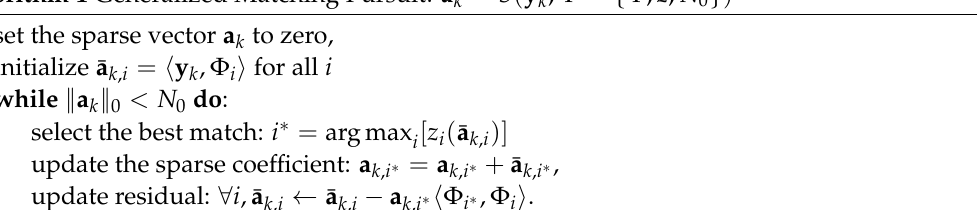
Algorithm 1 Generalized Matching Pursuit: a k = S ( y k ; Ψ = { Φ , z , N 0 } )